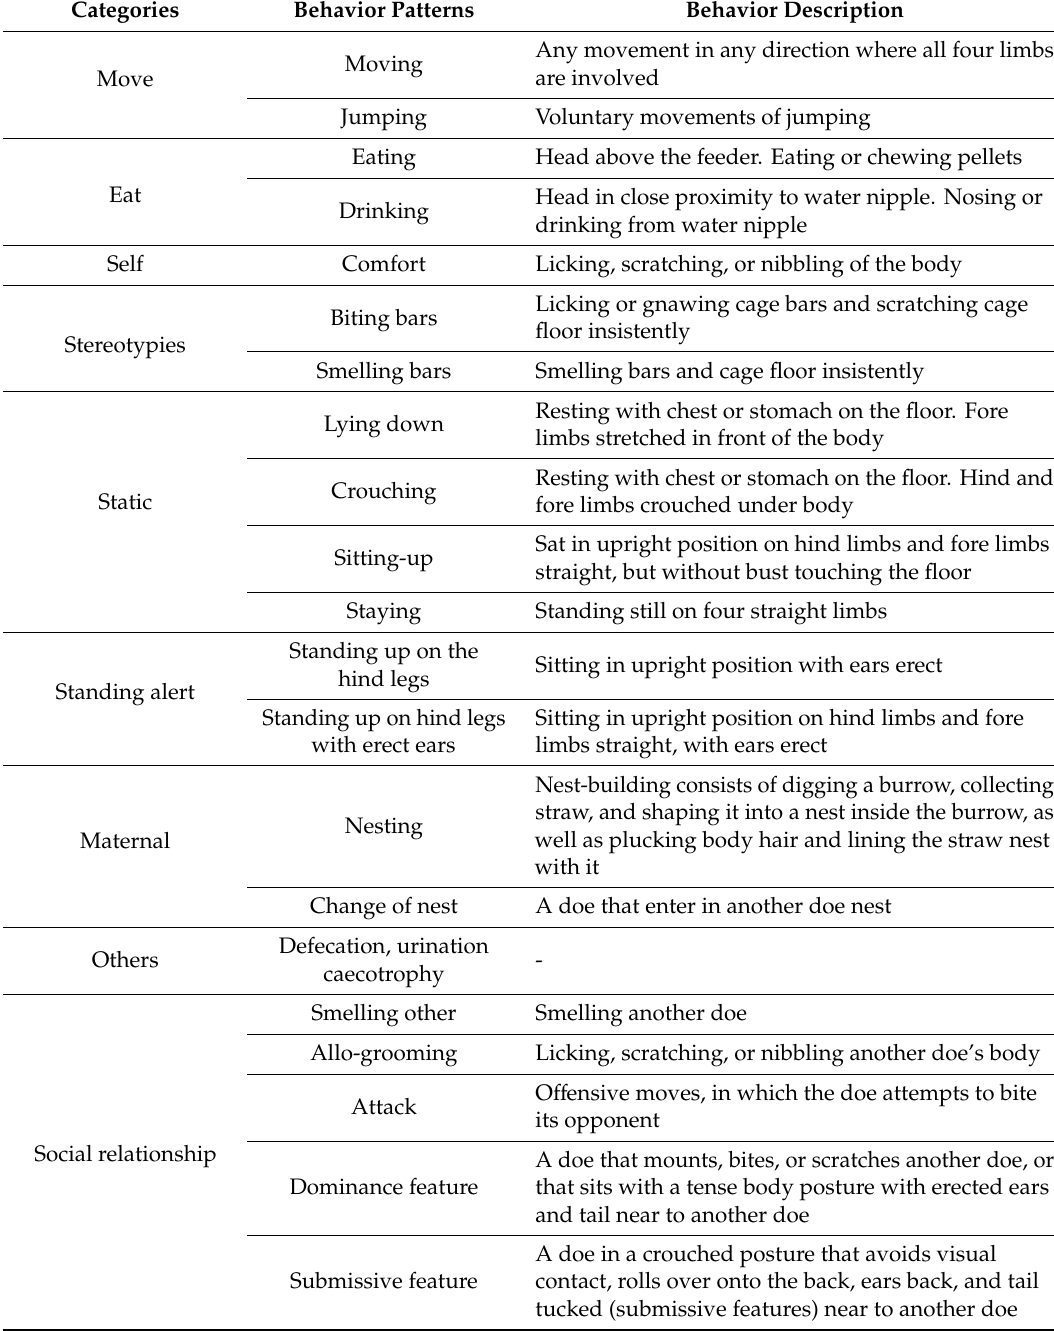
Table 1. Does’ ethogram, categories of behavior patterns, and behavior